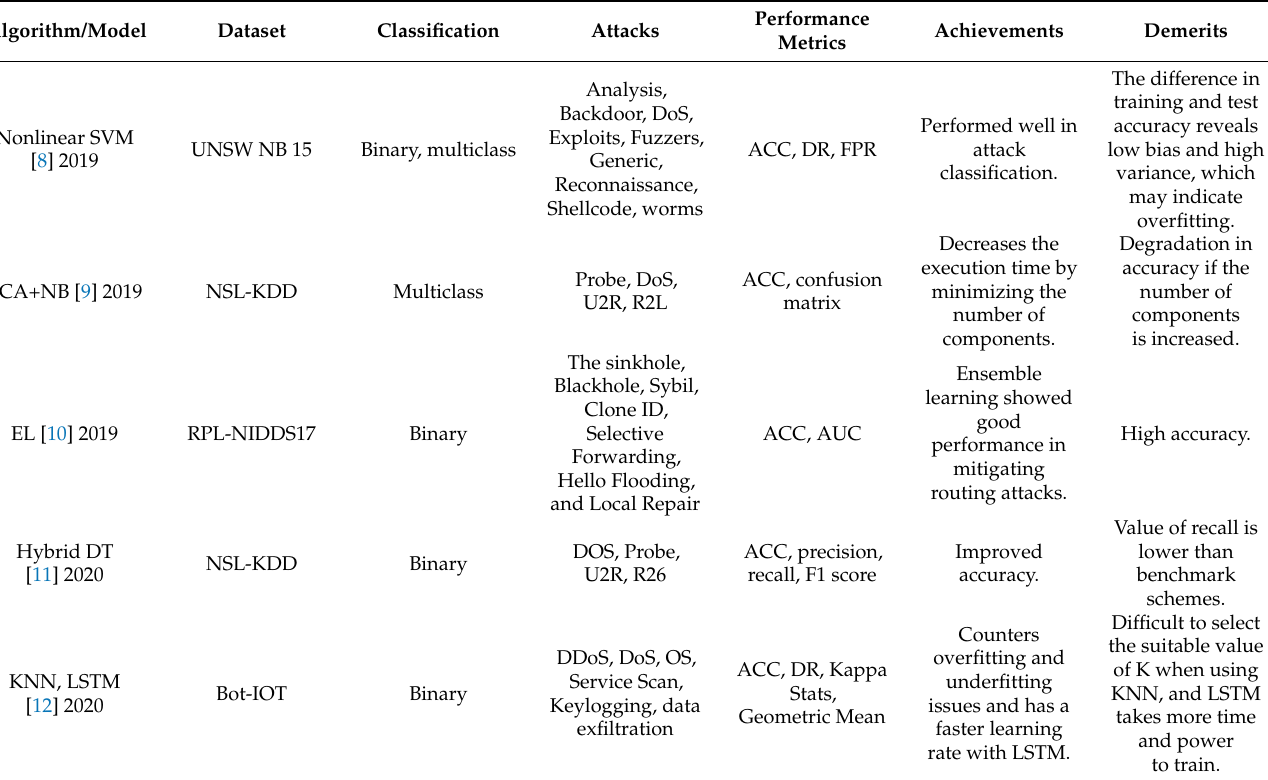
Table 1. Comparison of ML/DL schemes for